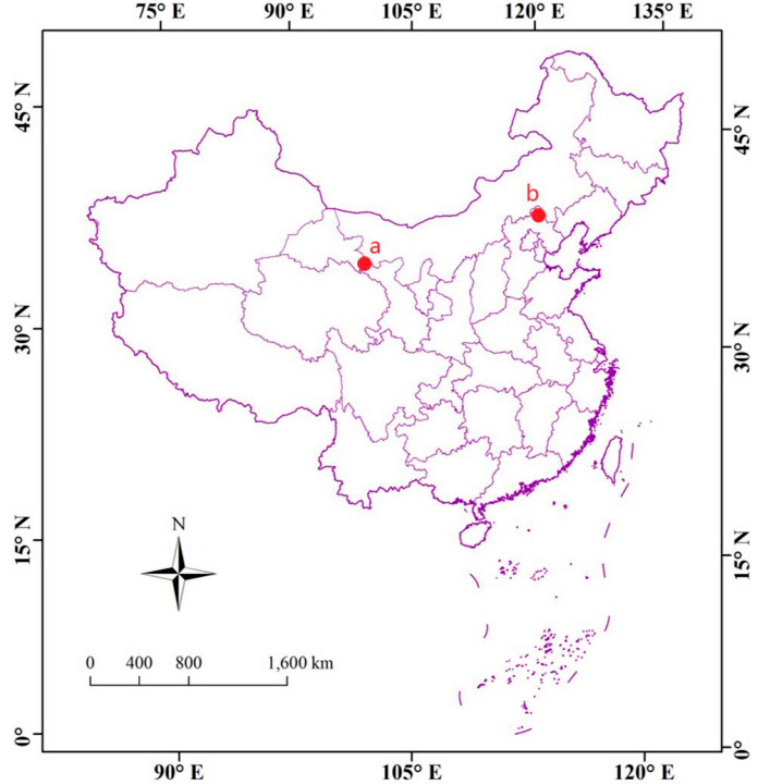
Figure 1. Location of Dayekou ( a ) and Saihanba ( b ) in China.